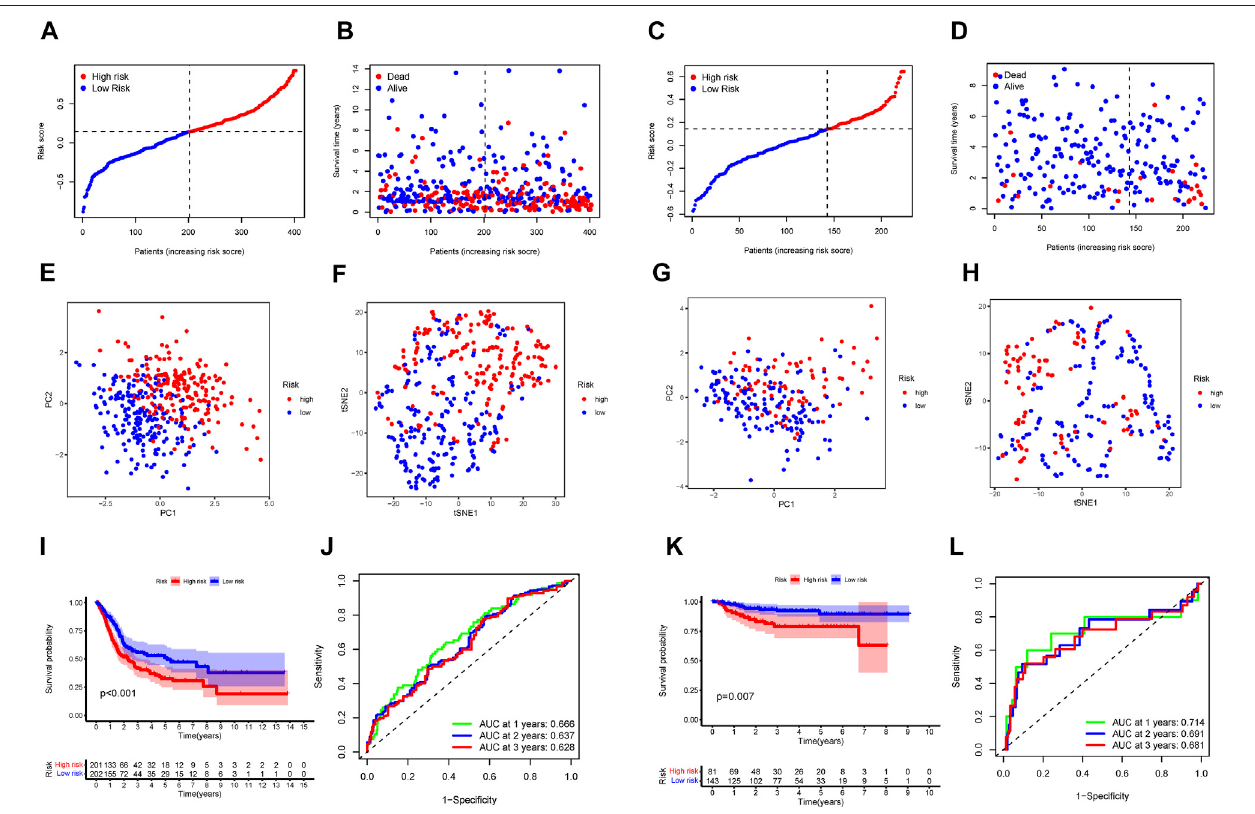
FIGURE3| TheIRGsprognosticmodelconstructedwiththeTCGAcohortandGSE32894.TCGAcohort (A,B,E,F,I,J) .GSE32894cohort (C,D,G,H,K,L) . (A, C) The median value and distribution of the risk scores. (B,D) The distribution of OS status. (E,G) PCA plot. (F,H) t-SNE analysis. (I,K) Kaplan – Meier curves for OS of patients in the high- and low-risk groups. (J,L) AUC time-dependent ROC curves for OS.